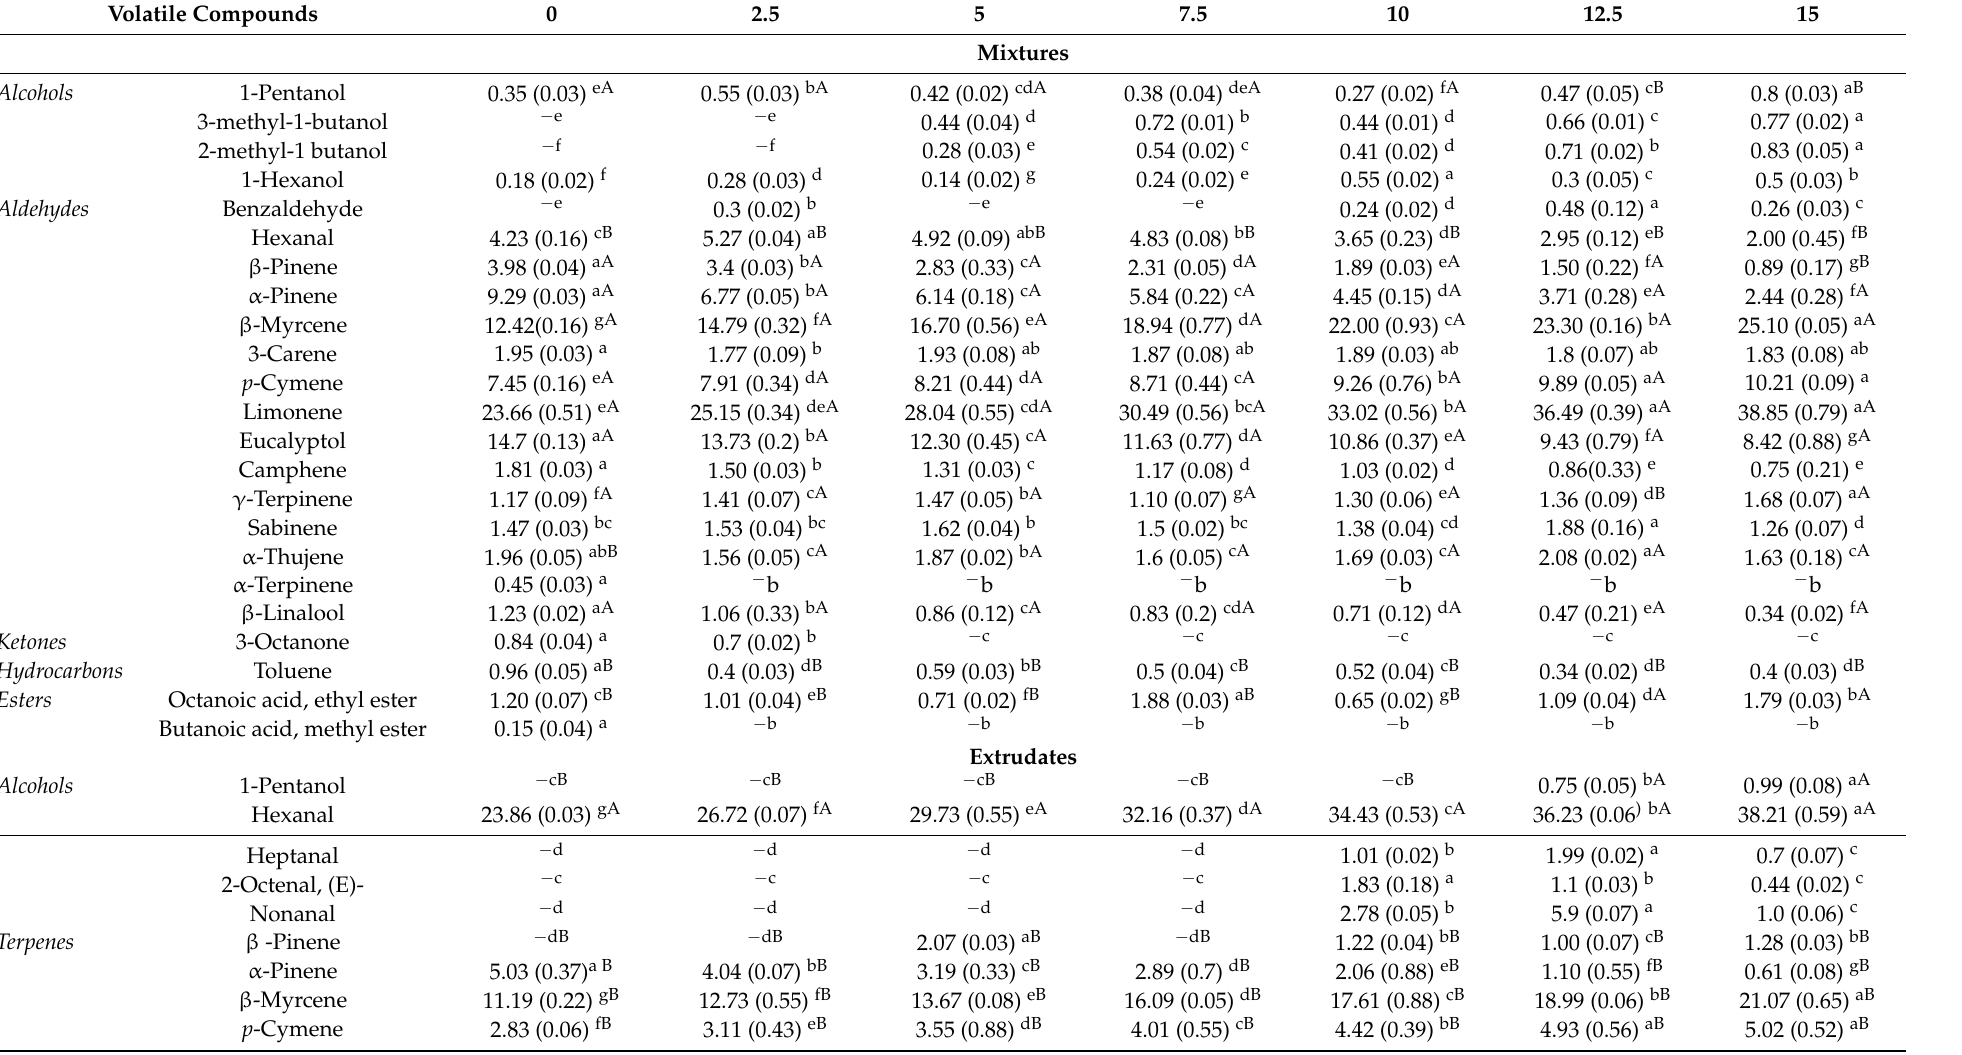
Table 7. Mean values (and standard deviation) of total peak area percentage of aroma compounds from mixtures and extrudates with 0–15%